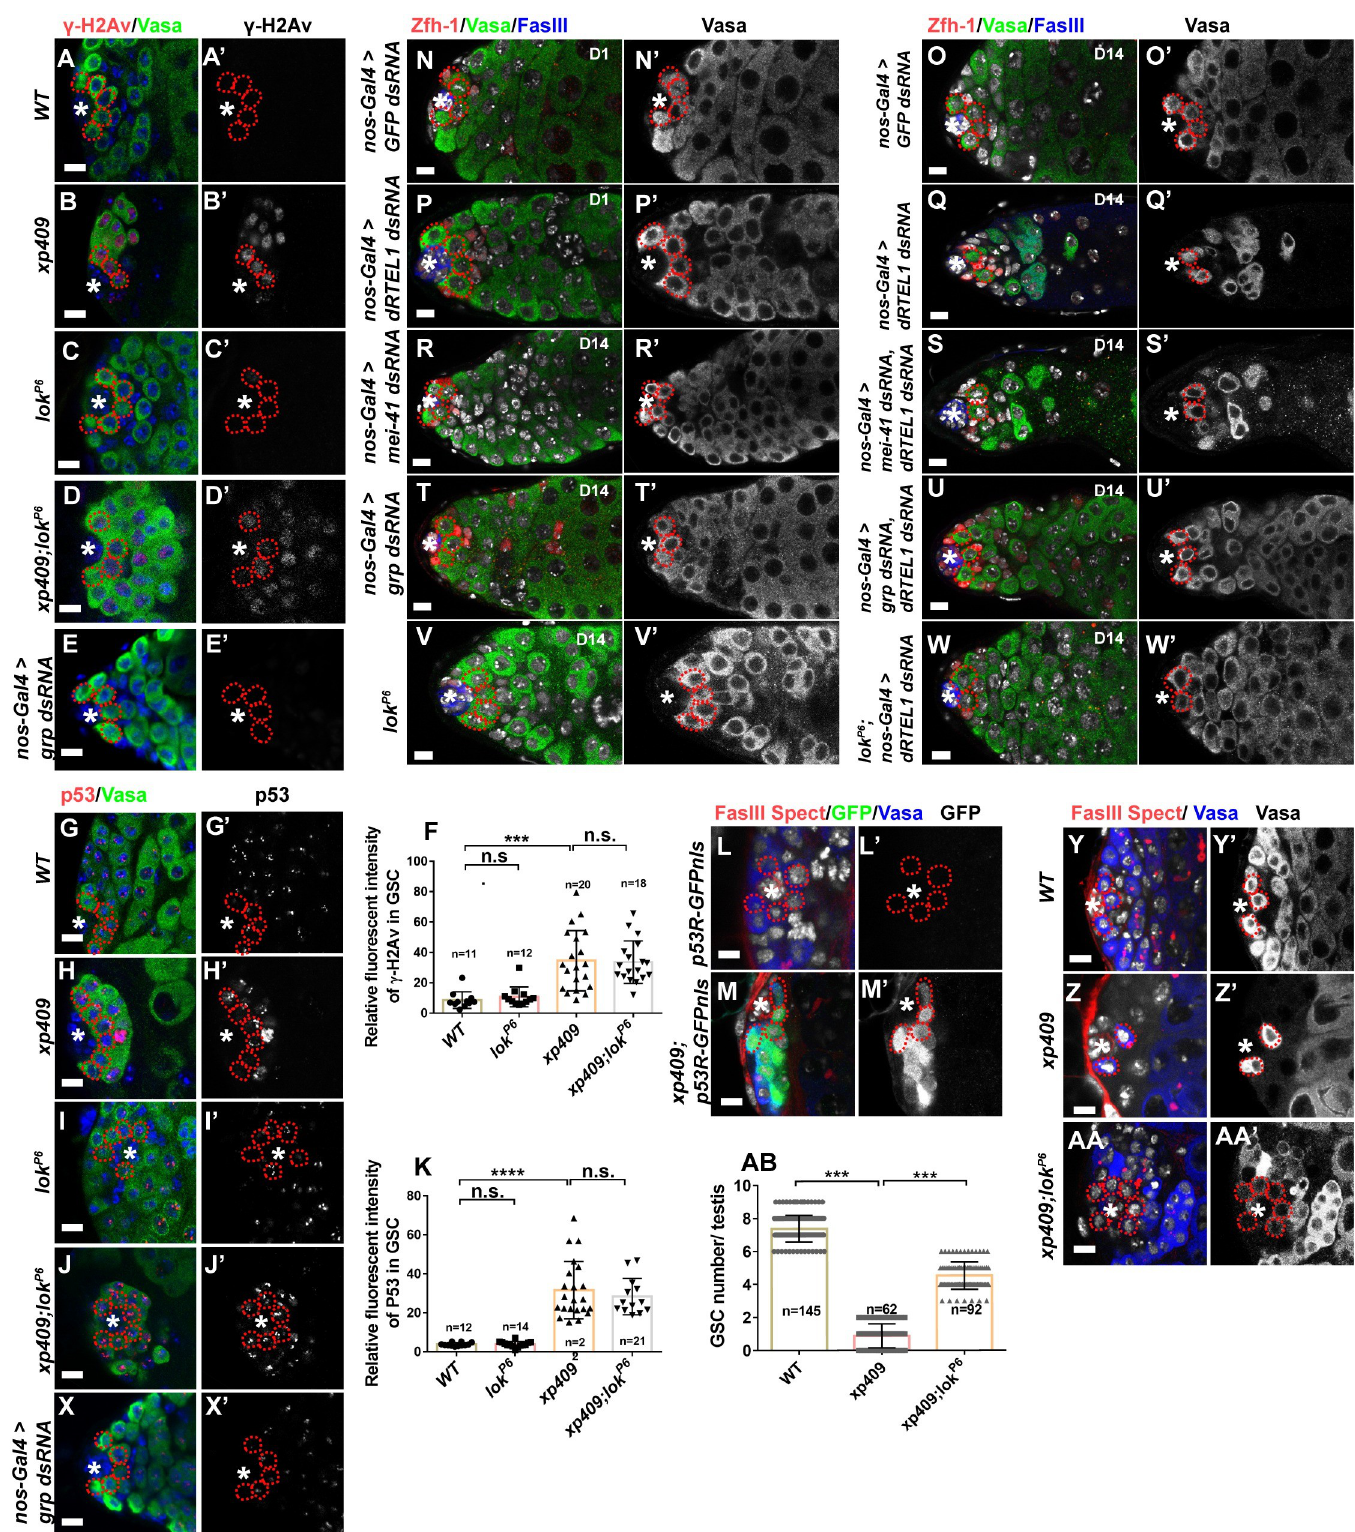
Fig 7. dRTEL1 maintains GSCs by preventing DNA damage-induced checkpoint activation. (A,A’) No γ -H2Av expression detected in WT larval testis at 72hr ALH. (B,B’) A xp409 larval testis at 72hr ALH showing γ -H2Av accumulation in GSCs. (C,C’) A lok P6 larval testis at 72 hr ALH showing no γ -H2Av in GSCs. (D,D’) A